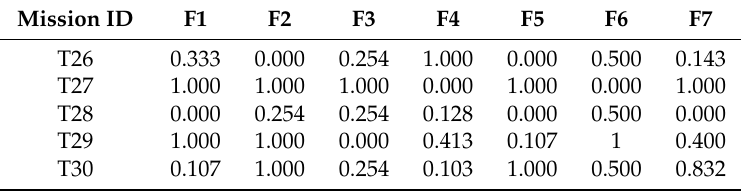
Table 9. Standard matrix of priority impact factors for newly arrived